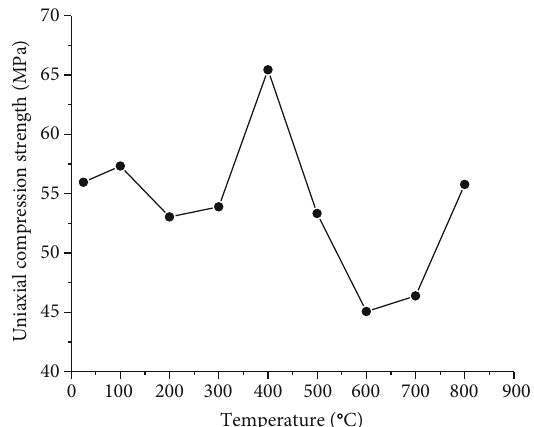
Figure 5: Uniaxial compressive strength of heat-treated sandstone.